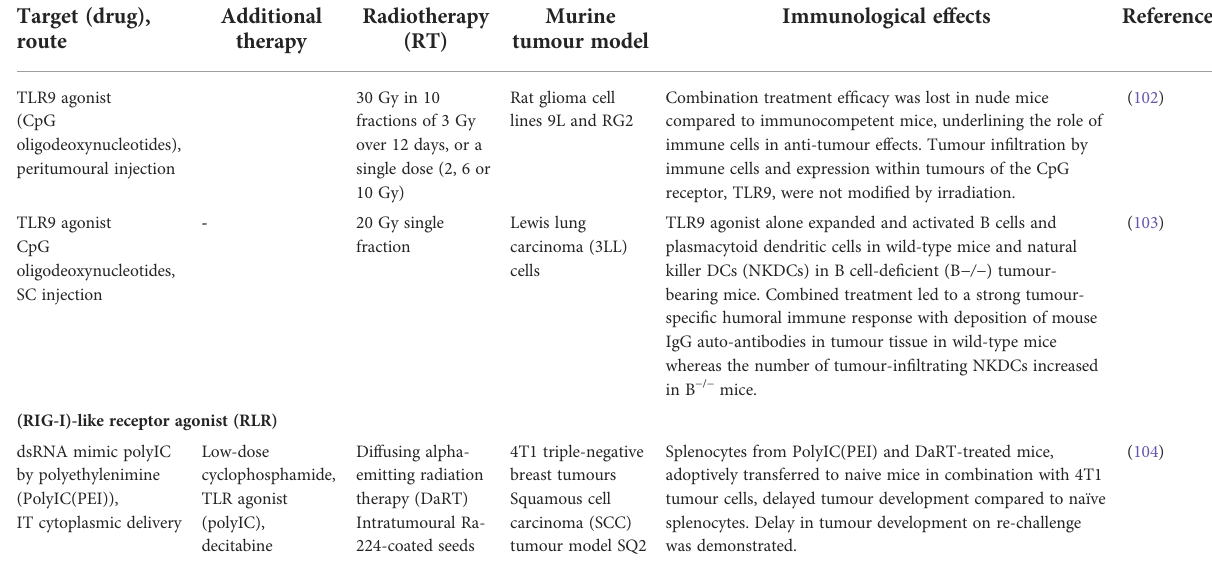
clinical trial in brain cancer (NCT03423628). A dual ATM and DNA-PKc inhibitor (XRD-0394) and radiotherapy phase I trial is also recruiting (NCT05002140) (Table